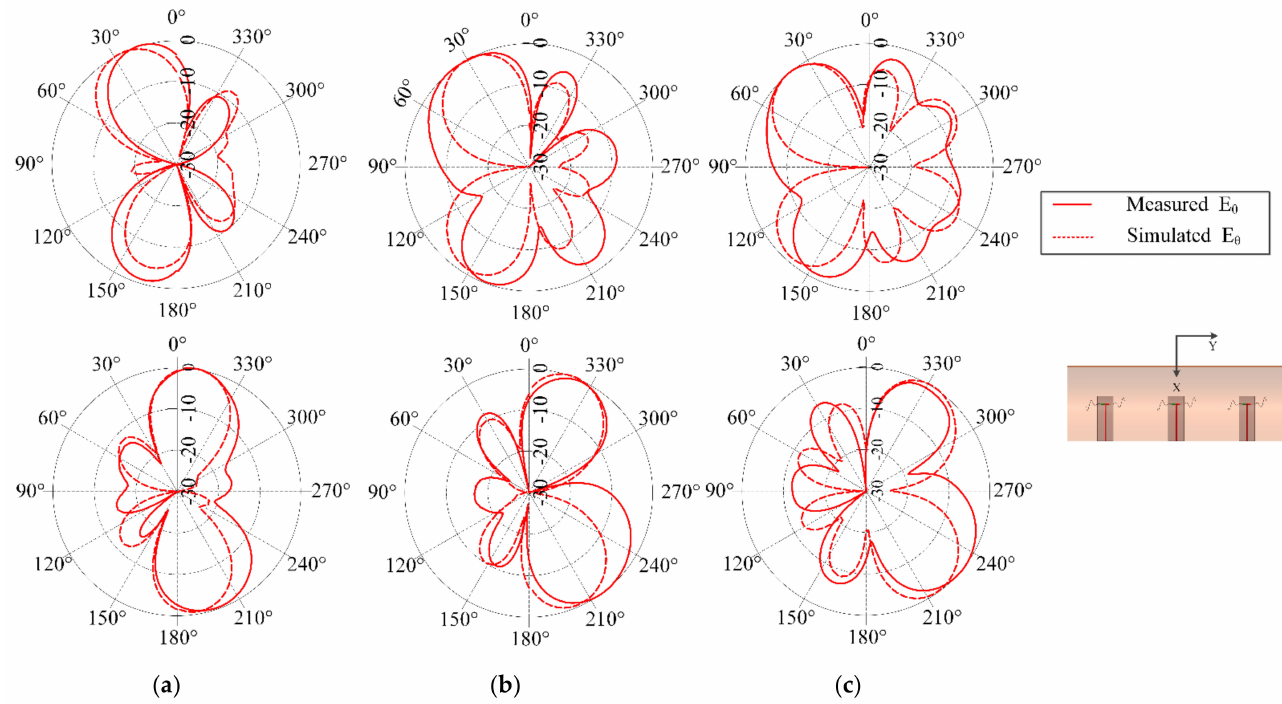
Figure 10. Beam scanning of multi-element SEVA-CLA for different scan angles at with channel filling factor t = 1.55 in. operating at 824 MHz ( a ) Radiated beam at ± 15 ◦ ( b ) Radiated beam at ± 30 ◦ ( c ) Radiated beam at ± 45 ◦